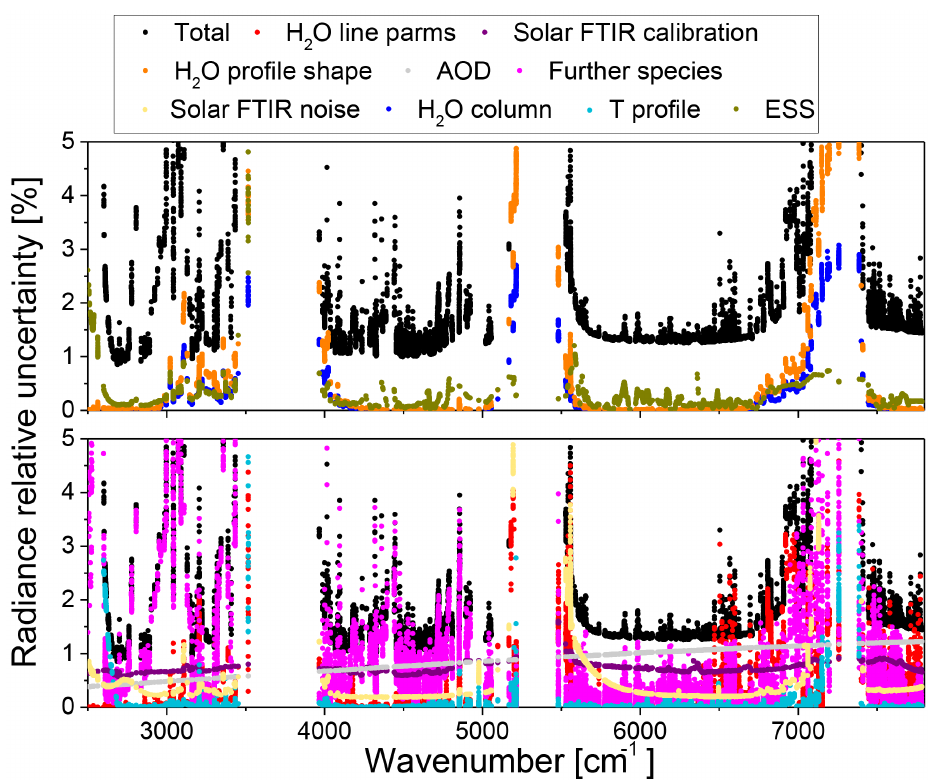
Figure 9. Residual uncertainty (2 σ , relative to measured solar radiance) of the NIR closure experiment for a single solar FTIR spectrum and for the mean atmospheric state of the closure data set (IWV = 2.3mm; for more details, see Part 3). The total residual uncertainty (black) results from contributions by water vapor line parameter uncertainties (red; “parms” stands for parameters), IWV uncertainty (blue), temperature profile uncertainty (green), further trace gas column and line parameter uncertainties (cyan), AOD uncertainty (grey), solar FTIR calibration uncertainty (purple), and solar FTIR measurement noise (orange). Representation corresponds to the mean atmospheric state of the water vapor continuum quantification data set and the spectral windows used for continuum